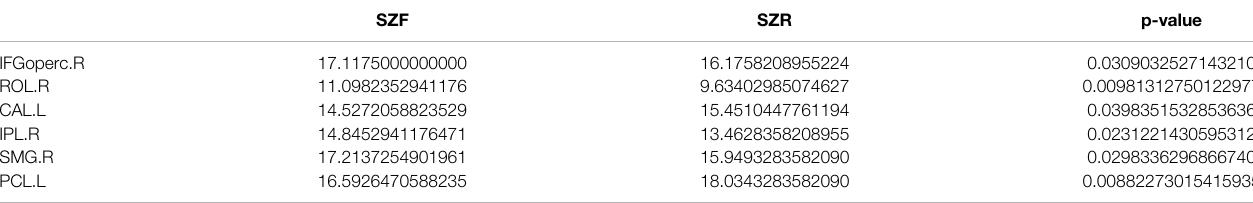
TABLE 3 | The 6 signi fi cant nodes with the average degree in the SZR and SZF groups. SZF SZR p-value IFGoperc.R